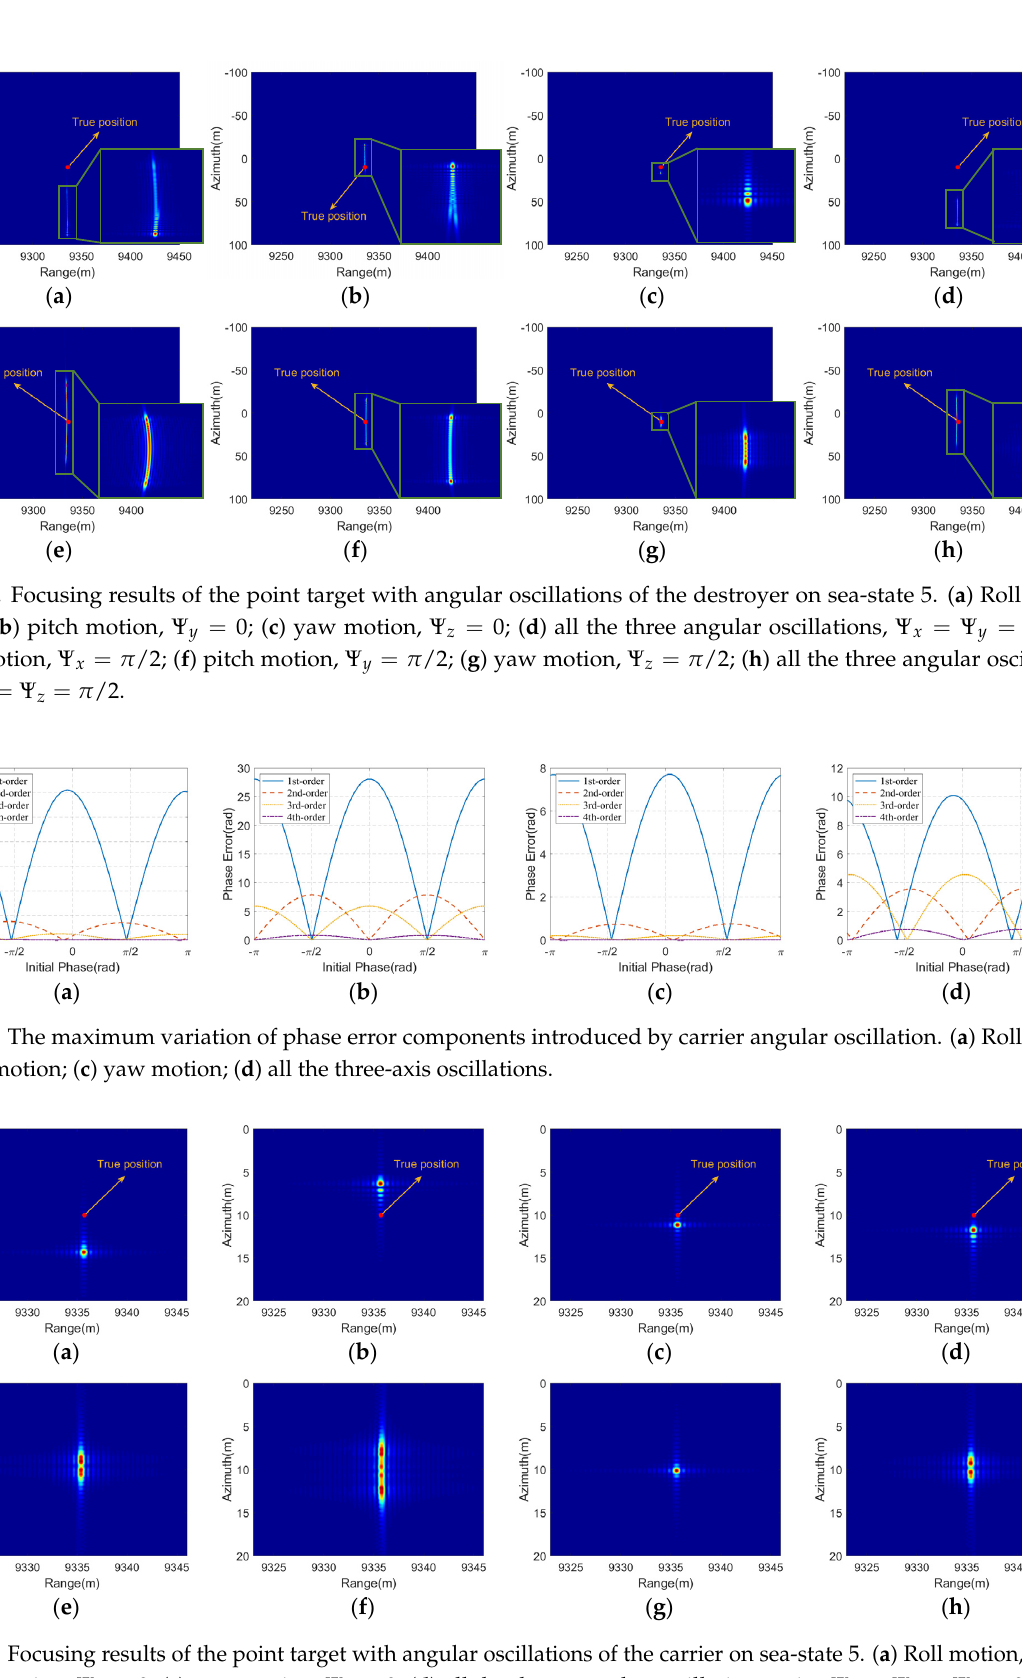
Figure 12. The maximum variation of each order phase error components introduced by destroyer angular oscillation. ( a ) Roll motion; ( b ) pitch motion; ( c ) yaw motion; ( d ) all the three angular oscillations.